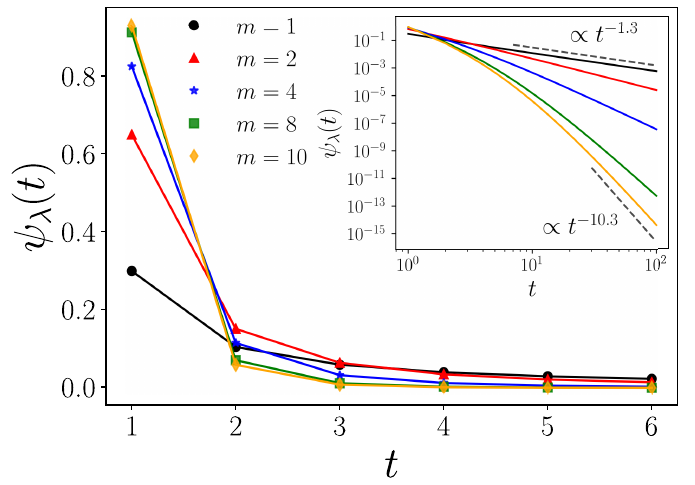
Figure 1. Generalized Sibuya distribution ψ λ ( t ) . We depict the GSD from Equation (27) for µ = 0.3 and different m ≥ 1. The inset shows the results in logarithmic scale for 1 ≤ t ≤ 100, we present with dashed lines the power-law relation ∝ t − m − µ associated with the asymptotic result in Equation (33) for m = 1 and m =